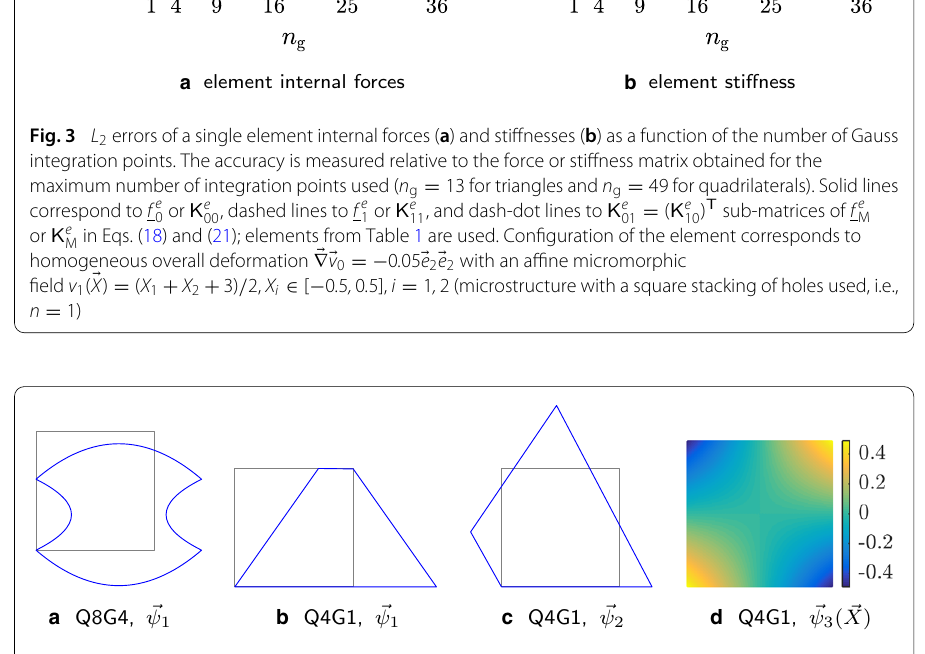
Fig. 4 A spurious singular mode observed for Q8G4 element in a , and three spurious singular modes for Q4G1 element in b – d (typical hourglassing modes are shown also in Fig. 1b). a – c correspond to deformed configurations for which the micromorphic field vanishes, i.e. v 1 ( (cid:2) X ) = 0, whereas d shows a surface plot of v 1 ( (cid:2) X ) for which the mean field vanishes, i.e. (cid:2) v 0 ( (cid:2) X ) = (cid:2) 0. Notation Q i G j designates a quadrilateral element with i nodes and j integration points. In all cases, bottom left node is fixed in both directions, whereas the right bottom node is fixed in the vertical direction to eliminate rigid body modes. A microstructure with a square stacking of holes used, i.e., n =